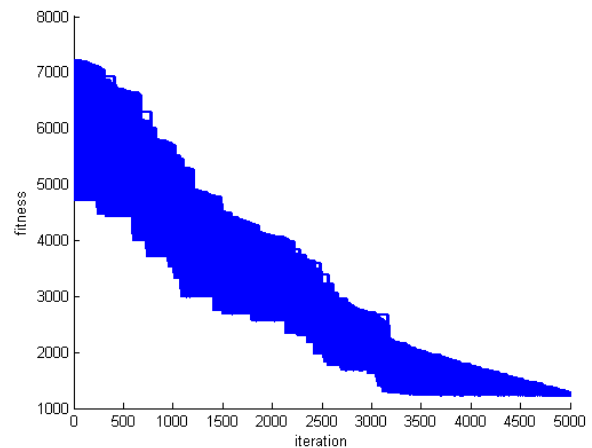
Figure 9. Whale fitness during motion in DS 5 .